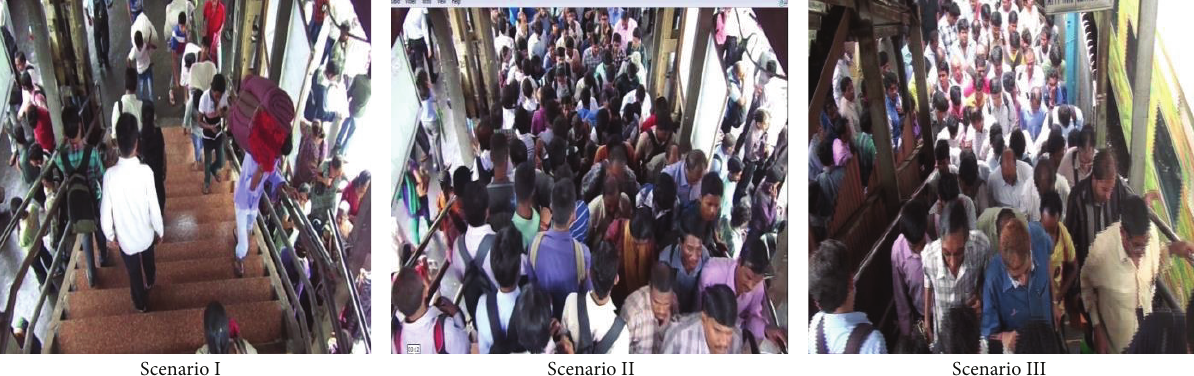
Figure 8: 1-minute pedestrian volume and average walking speed on Stair 2.